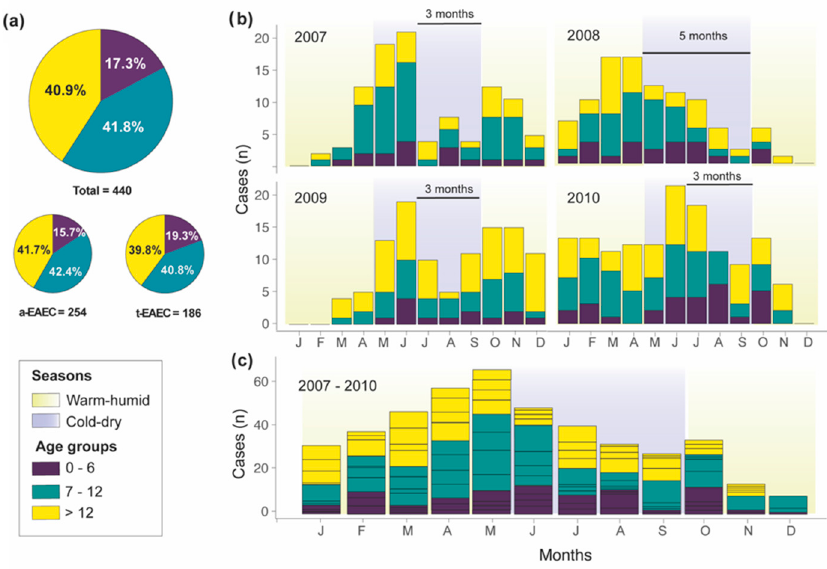
Figure 1. Age-wise and seasonal distribution of EAEC isolated from the stool samples of Bolivian children with acute diarrhea. ( a ) Age group stratification of EAEC isolated from diarrheal and non-diarrheal cases. ( b ) Seasonal distribution of age groups of EAEC isolates from diarrheal cases broken down per year or ( c ) accumulated.